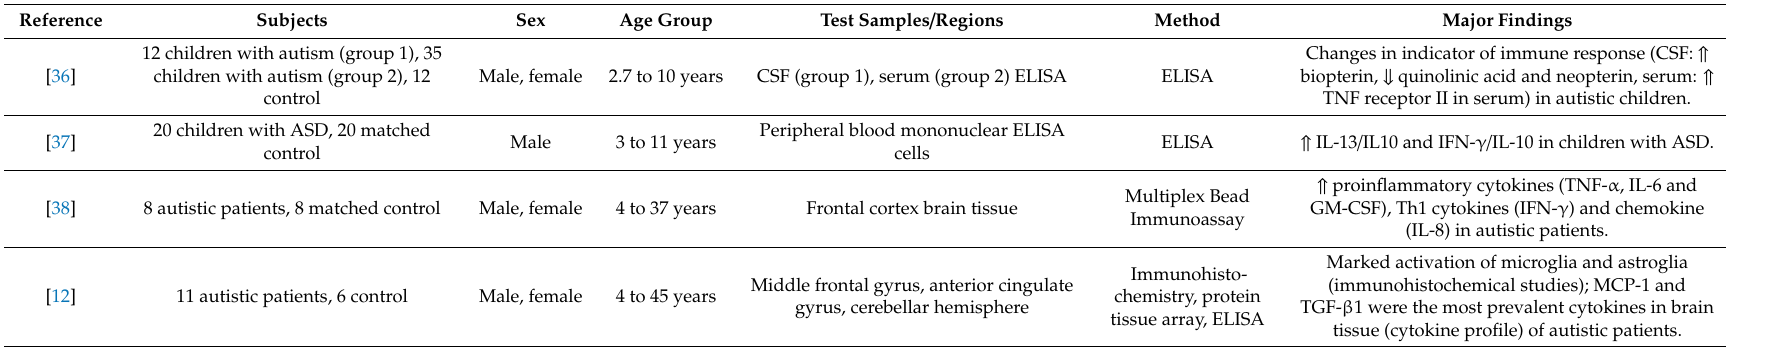
Table 2. Summary of previous studies on neuroglial activation and neuroinflammation in